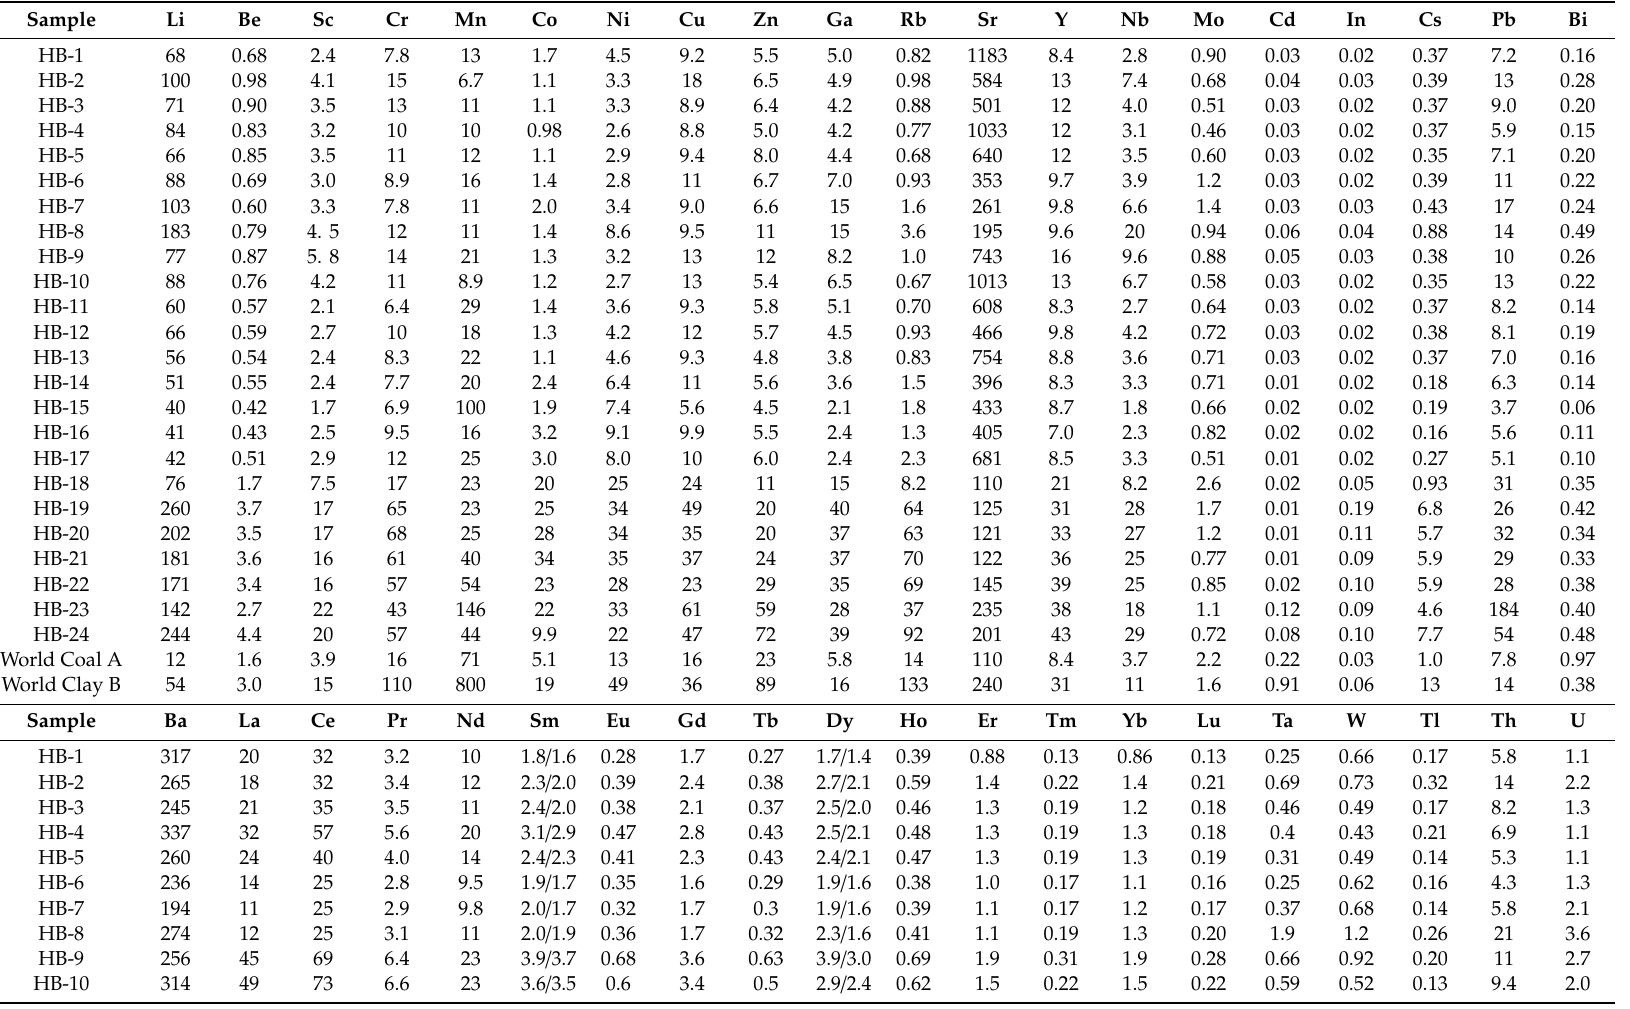
Table 5. Concentrations of trace elements in coal and non-coal samples from the Hebi No. 6 mine ( µ g / g, on a whole coal basis).